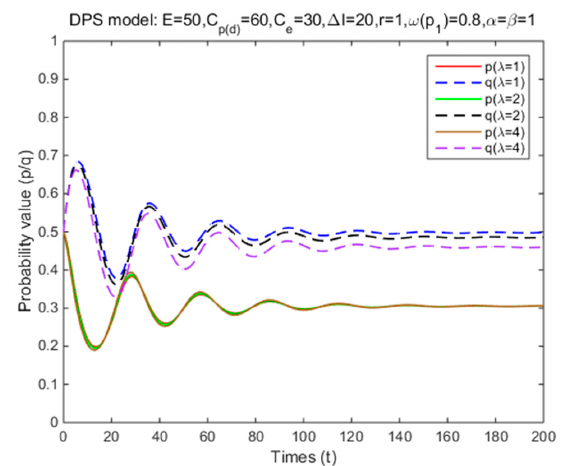
Figure 7. The effects of loss aversion coefficient on strategy probabilities of cyclists and law enforcement under DPS (Situation 3).